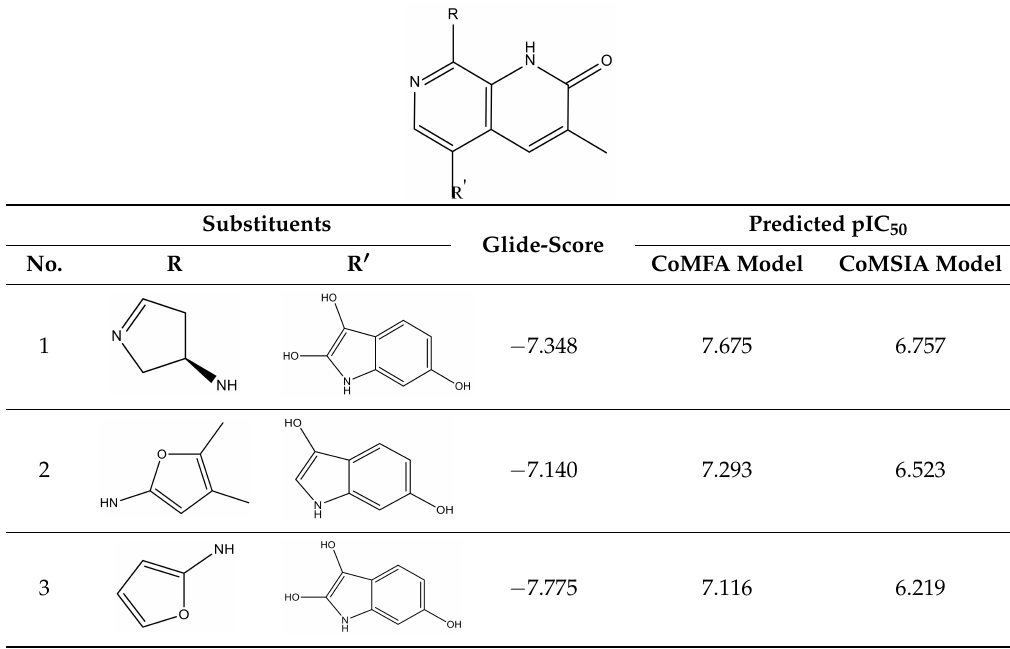
Table 3. Newly designed compounds structures with their docking scores and predicted biological